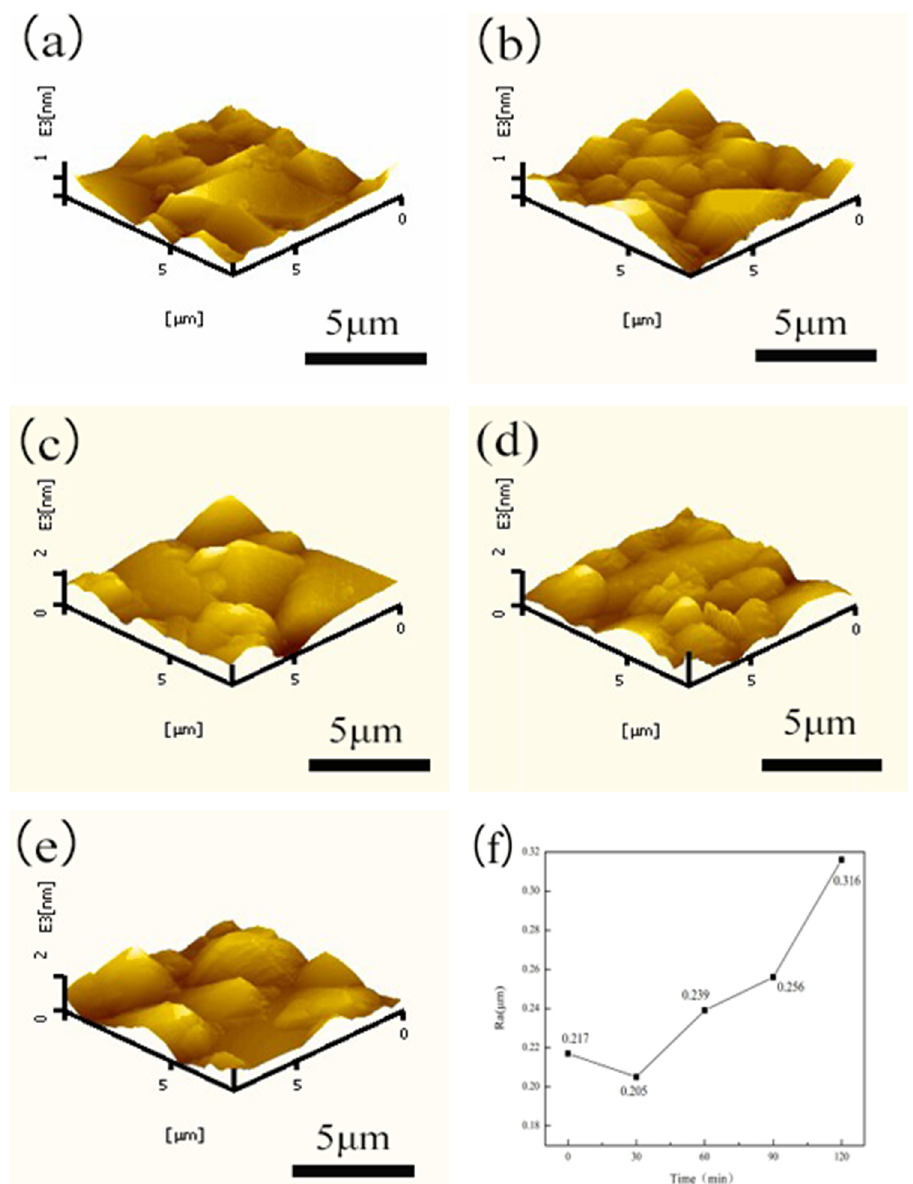
Figure 5: AFM images of samples etched at various times: ( a ) 0, ( b ) 15 min, ( c ) 20 min, ( d ) 60 min, ( e ) 90 min, and ( f ) 120